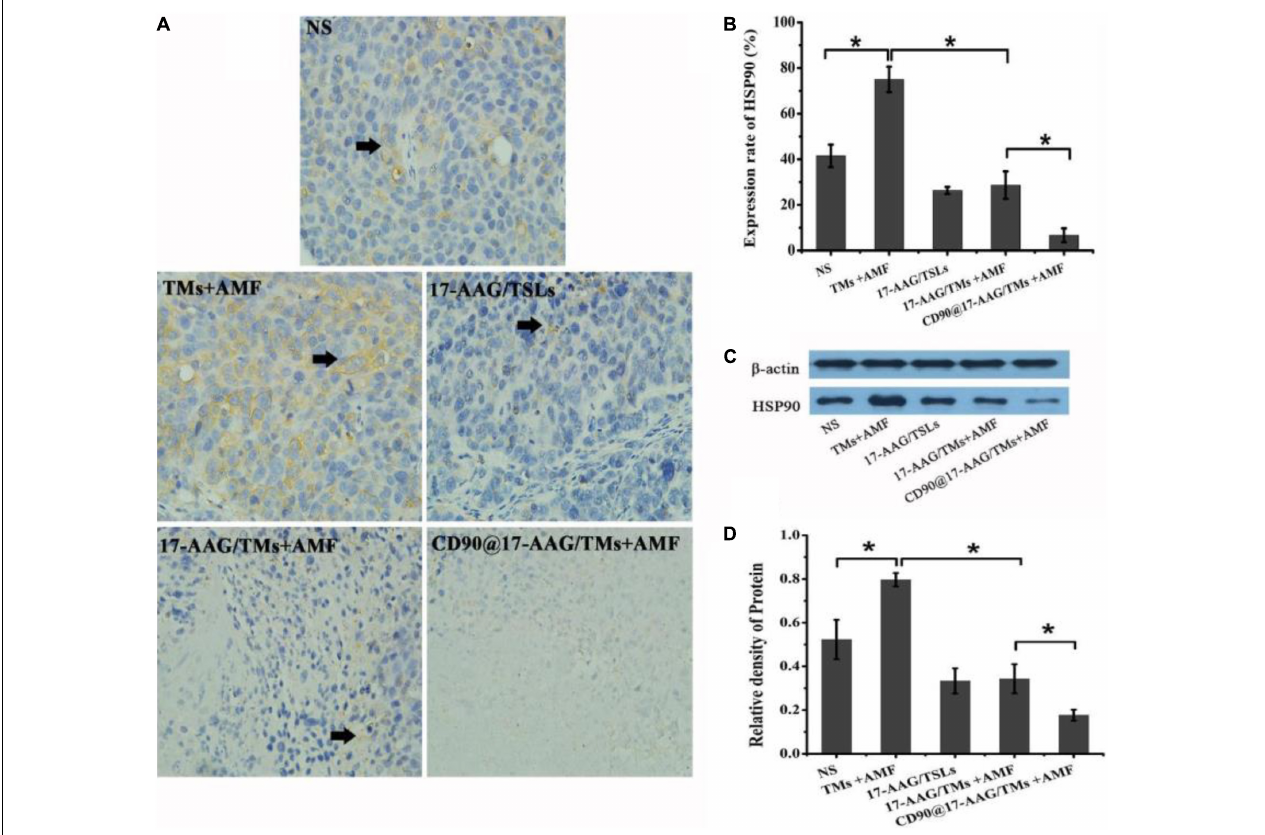
FIGURE 6 | Antitumor mechanism of CD90@17-AAG/TMs in CD90 + LCSC-bearing mice. (A) HSP90 IHC staining of tumor tissues in different groups ( × 40). (B) Expression rate of HSP90, * p < 0.05. (C) HSP90 expression observed using Western blot analysis. (D) Relative density of HSP90, * p <